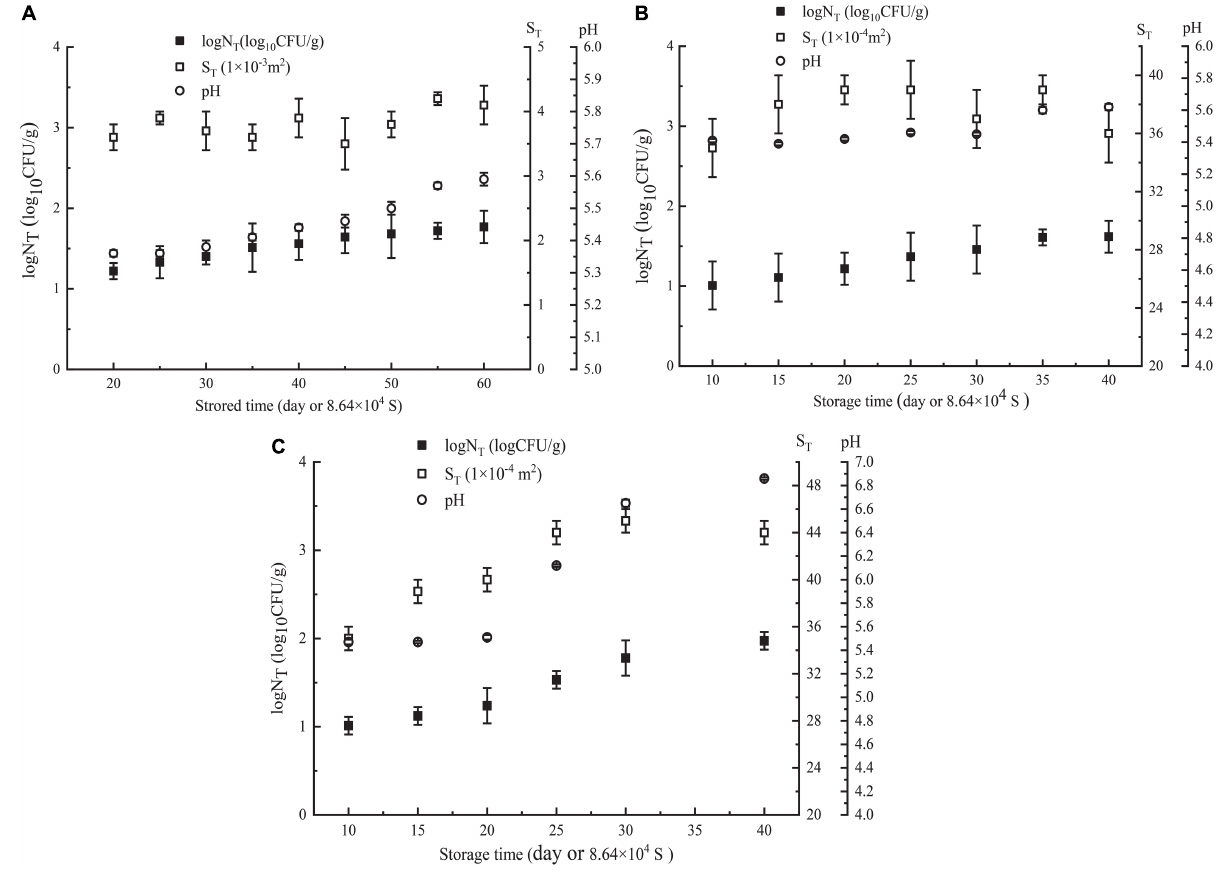
Frontiers in Microbiology |